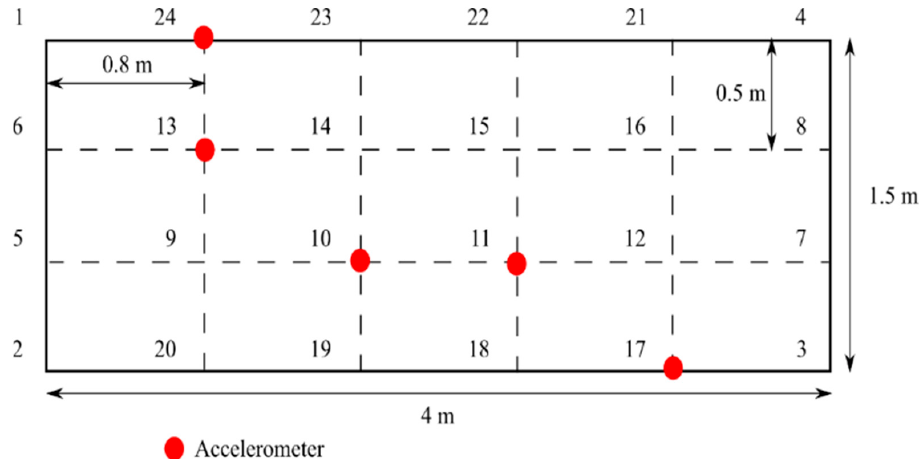
Figure 2. Mesh on the CLT panel. Five accelerometers (red dots) were placed at points 10, 11, 13, 17, and 24), whereas the hammer was moved around all nodes, except on the short edges.